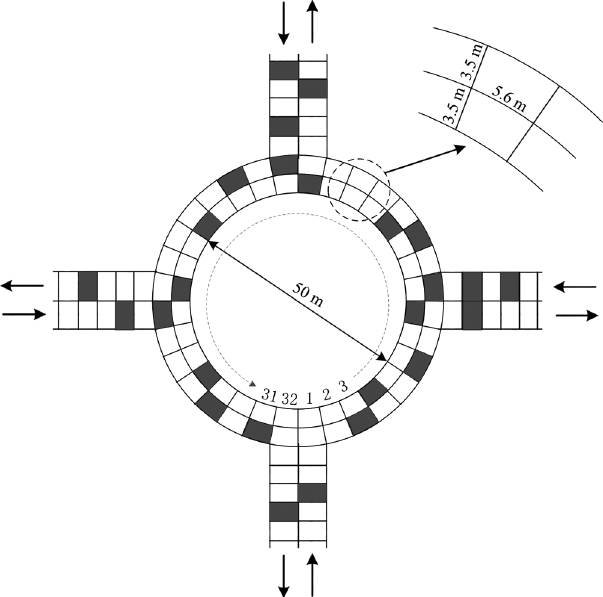
Figure 1. Schematic diagram of the cellular automaton traf fi c fl ow model for two-lane